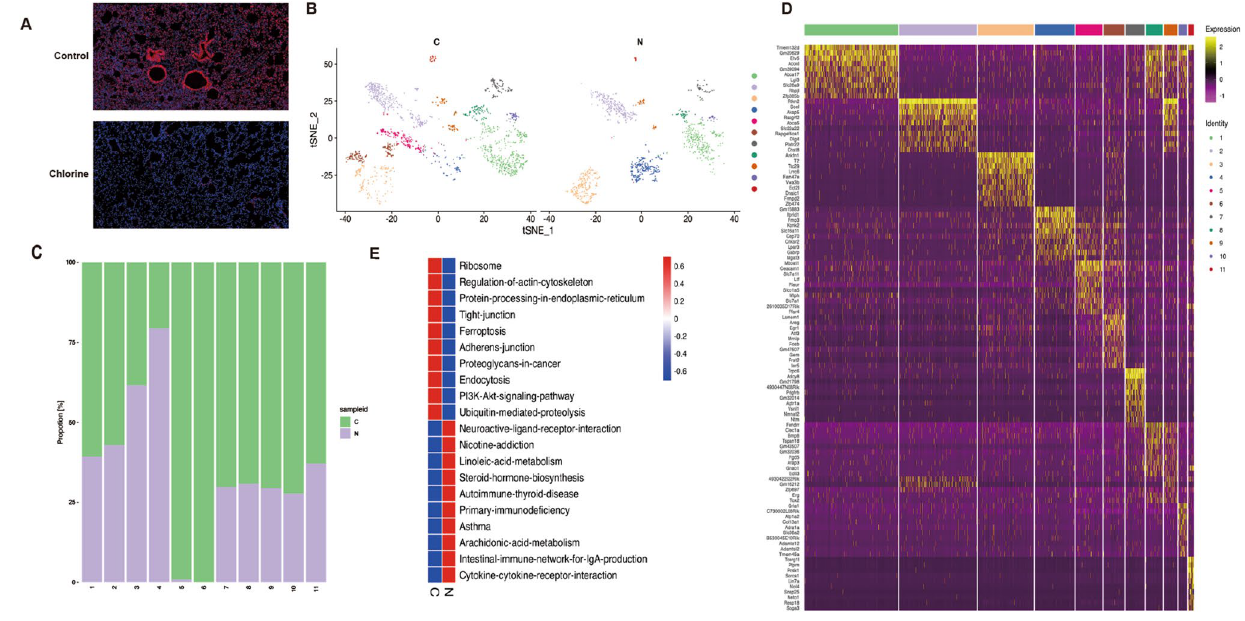
Figure 2. The single-cell transcriptomes of epithelial cells. ( A ) Immunofluorescence staining of epithelial cell CK8 gene in normal (n = 6)/Cl 2 -exposed (n = 6) lung tissues, scale bars 50 μm, CK8 (red), cell nuclear (blue). ( B ) The t-SNE plot and overview of the epithelial cells. ( C ) Proportions of normal and Cl 2 injury epithelial cells in each subgroups. Raw data of proportions of epithelial cells are shown in Supplementary information 3. ( D ) The heatmap shows the top 10 SDE genes in each subgroups of epithelial cells. ( E ) GSVA analysis indicated enrichment pathways of each subgroups of epithelial cells. N control group, C Cl 2